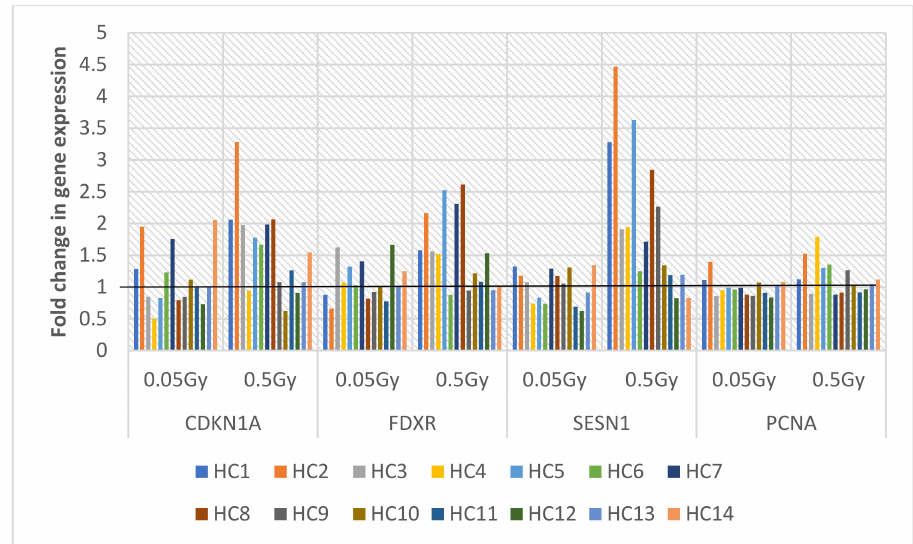
Figure 3. MQRT-PCR of 4 target genes CDKN1A, FDXR, SESN1 and PCNA for 14 healthy control donor samples exposed to 0.05 Gy and 0.5 Gy. The fold change threshold is displayed at 1 with a black line traversing each